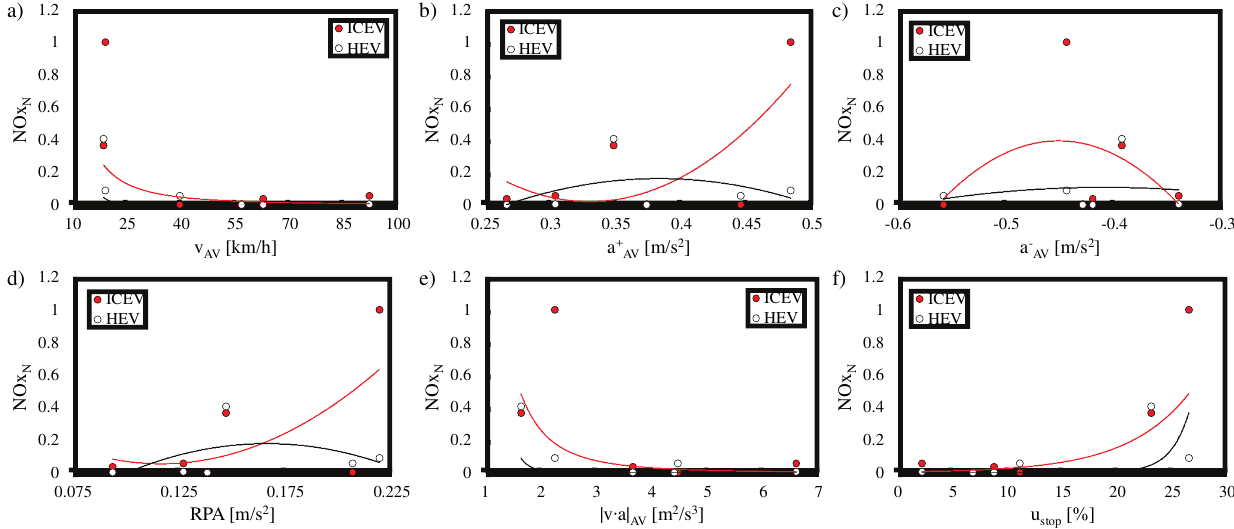
Fig. 3. The dependence of normalized road emission of nitrogen oxides on driving pattern parameters: average speed (a), average acceleration (b), average deceleration (c), relative positive acceleration (d), average absolute value of the product of speed and acceleration (e), time share of vehicle stop